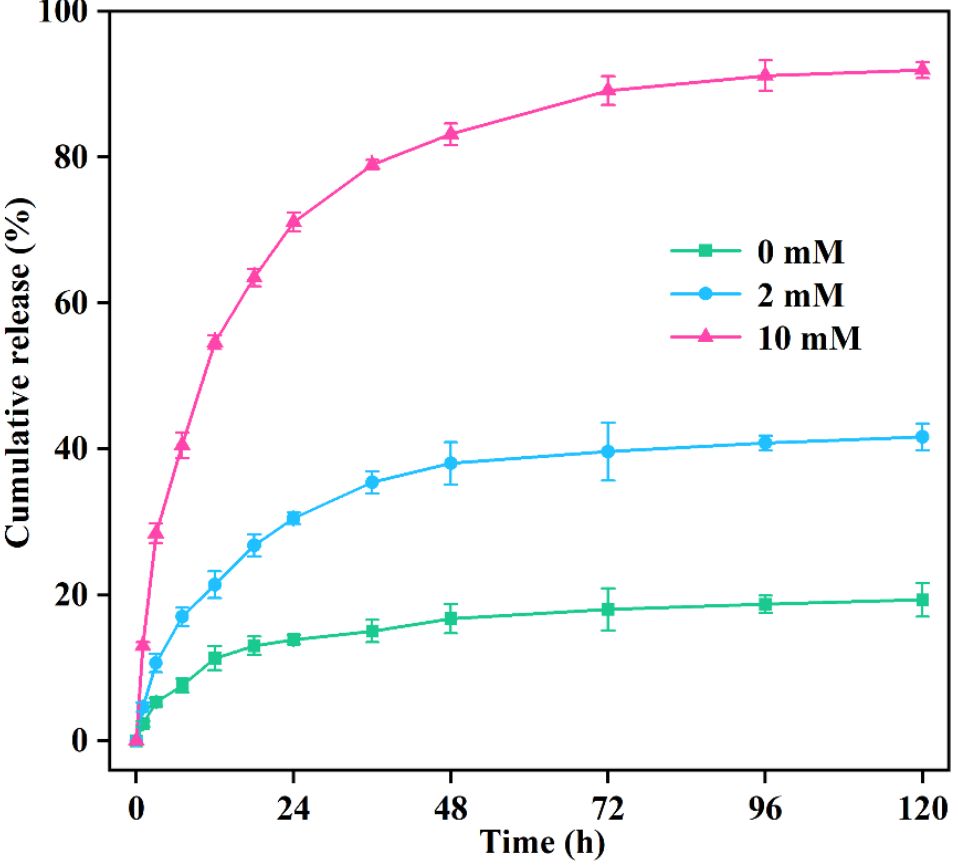
Figure 6. Effect of glutathione on the release performance of prochloraz from PRO@DMON–GA– Fe(III) nanoparticles. Table 2. Determined parameters of prochloraz released from PRO@DMON–GA–Fe(III) nanoparticles by fitting several kinetic